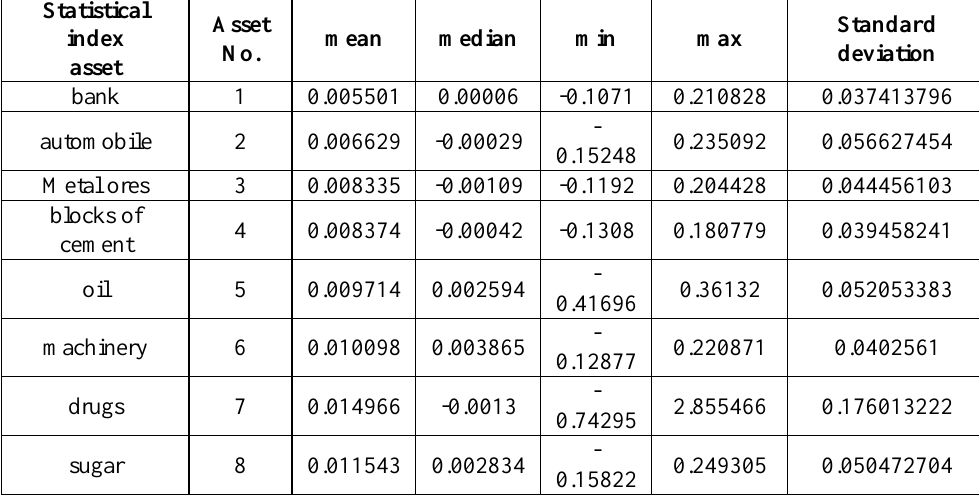
Table 1. Descriptive statistics of weekly return on portfolio assets